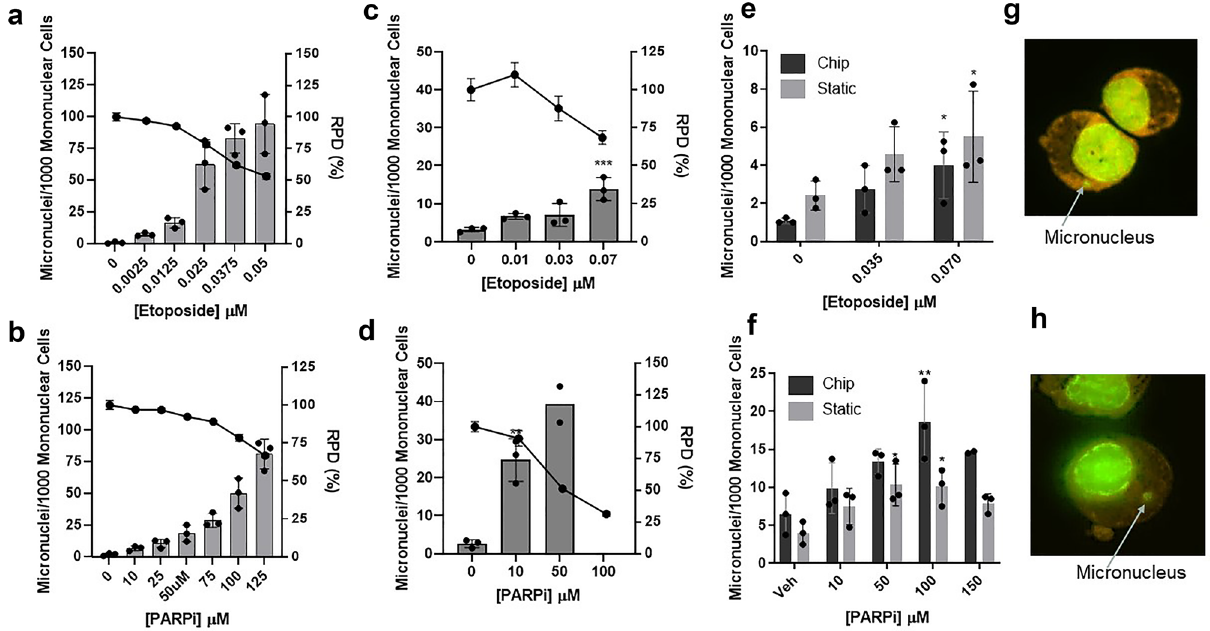
with etoposide ( a ) or PARPi ( b ), in 2D BM cells following treatment with etoposide ( c ) or PARPi ( d ), and in the 3D chip and static models following treatment with etoposide ( e ) or PARPi ( f ). Representative MN images (×40) from the chip ( g ) and static ( h ) models. Data are presented as mean ± SD, n = 3. Bars represent MN/1000 cells; lines represent relative population doubling (RPD), a measure of cytotoxicity in the L5178Y assay, or % cell viability (ATP measurement) in the 2D BM assay; images of MN were stained with acridine orange, which stains double stranded DNA green (nucleus) and RNA red/orange (cytoplasm), arrows indicate a MN and are representative of MN scored; n = 3 (n = 2 for 50 µM PARPi in 2D, 150 µM PARPi in chip). Significance compared to vehicle control (one way ANOVA with Dunnett’s post-test; * p < 0.05; ** p < 0.01; *** p < 0.001; **** p <